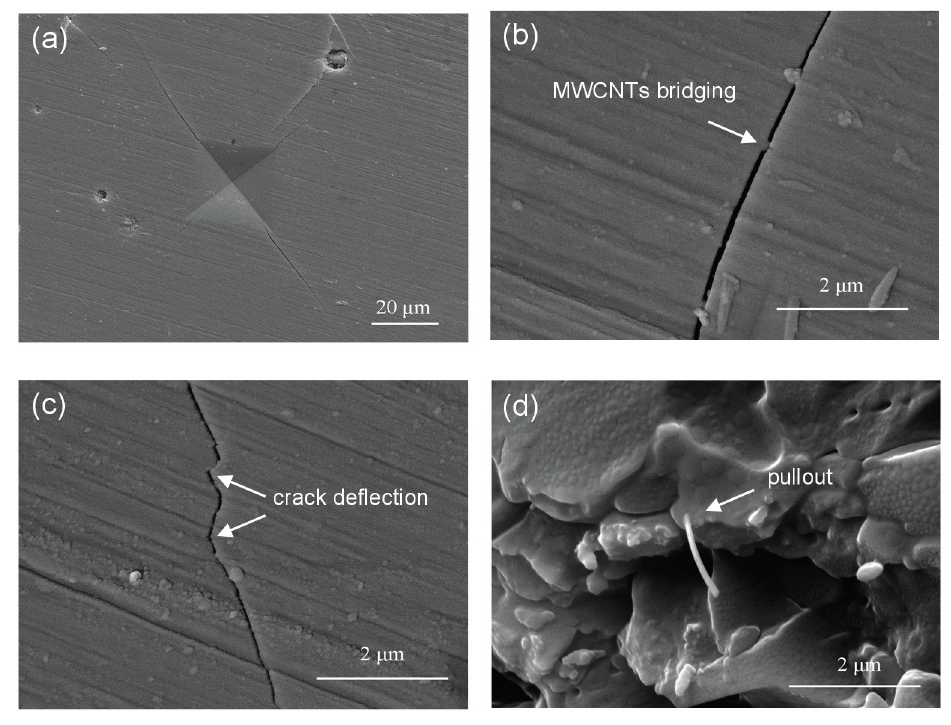
Figure 4. SEM of ( a ) indentation crack propagation of Di scaffold with 2 wt % MWCNTs; ( b ) MWCNTs crack bridging; ( c ) crack deflection; ( d ) MWCNTs pull-out at the fracture surface of the